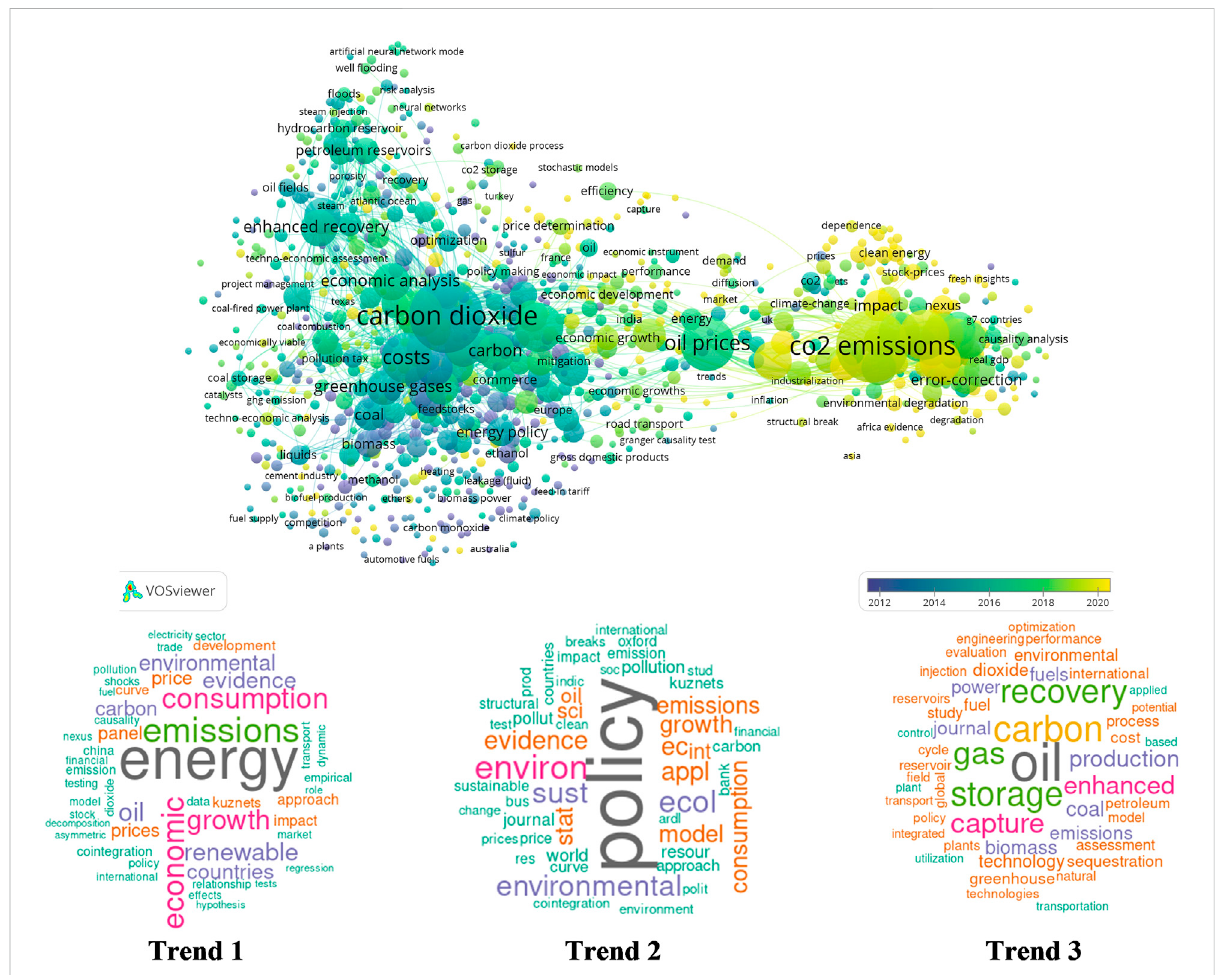
FIGURE 3 Relationships of the most signi fi cant studies and research trends of linkages among green bonds, CO 2 emissions, and oil prices. Source: Authors ’ own research using VosViewer, Bibliometrix tools, as well as Scopus and WoS